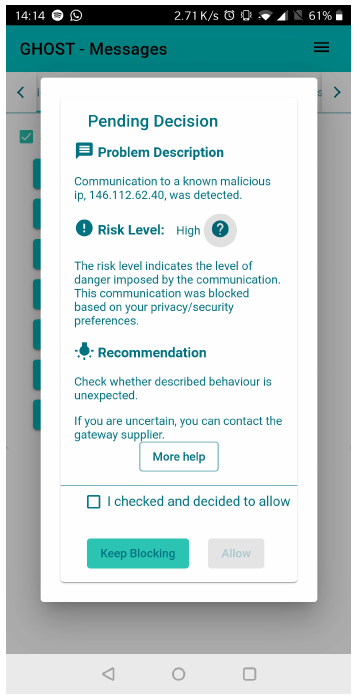
Figure 13. Pending